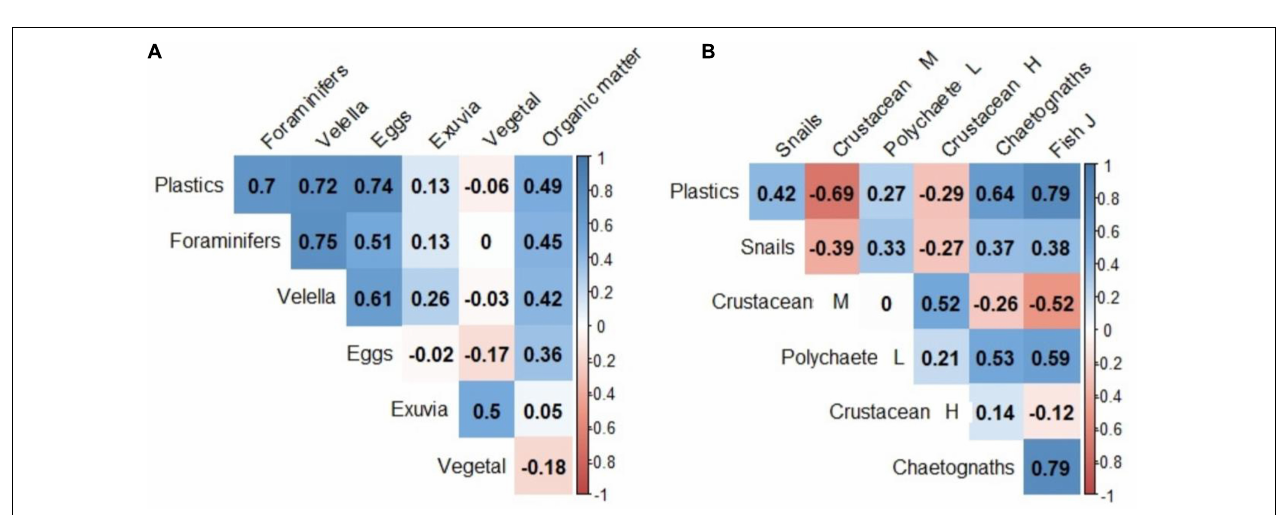
FIGURE 6 | Main motile organisms. Density of organisms found inside and outside the slicks in 2018 (A) and 2019 (B) . The groups are ordered by their mobility in the water column. Plastic density is shown for reference purposes. Insert shows less abundant groups with a different scale for better reference.